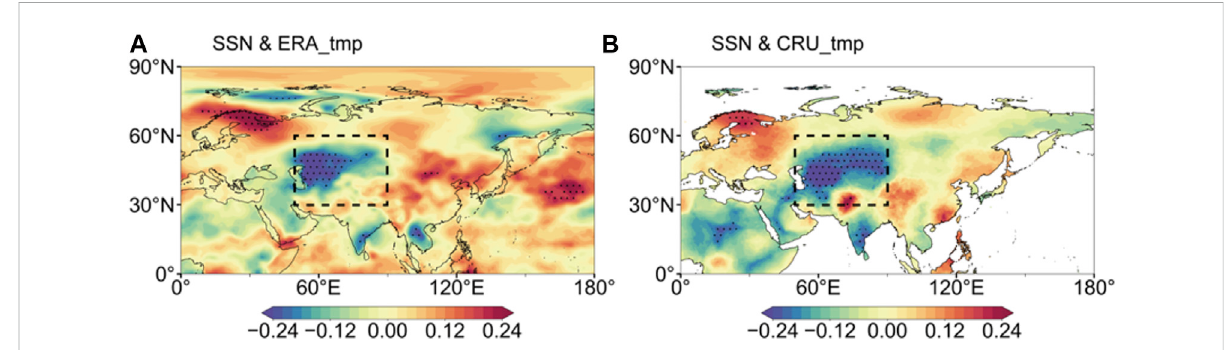
FIGURE 4 Correlation maps between detrended summer temperature and SSN over Eurasia during 1901 – 2010. Black dotted regions are above 95% con fi dence level. Central Asia (30 ° N – 60 ° N and 50 ° E – 90 ° E) is marked by the black dashed frame. (A) SSN and ERA_tmp. (B) SSN and